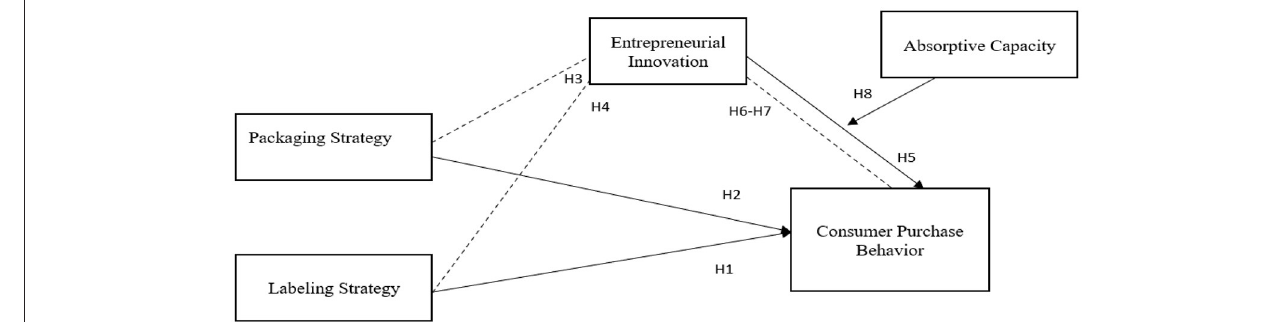
FIGURE 1 | Conceptual framework.